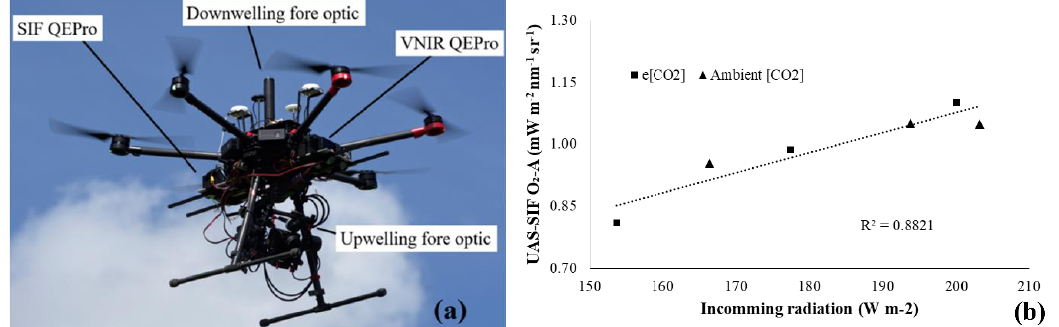
Figure 3. ( a ) Instrument presented by [33] and used by [31,44], highlighting the position of the solar induced ChlF (SIF) QEPro, downwelling and upwelling fore optics and VNIR QEPro (source: Dr. Andrew Revill, BBSRC/NERC ATEC project at University of Edinburgh-GeoSciences); and ( b ) the relationship between incoming radiation and SIF under ambient and elevated [CO 2 ] in a mature oak forest, measured at the BIFoR FACE site in the